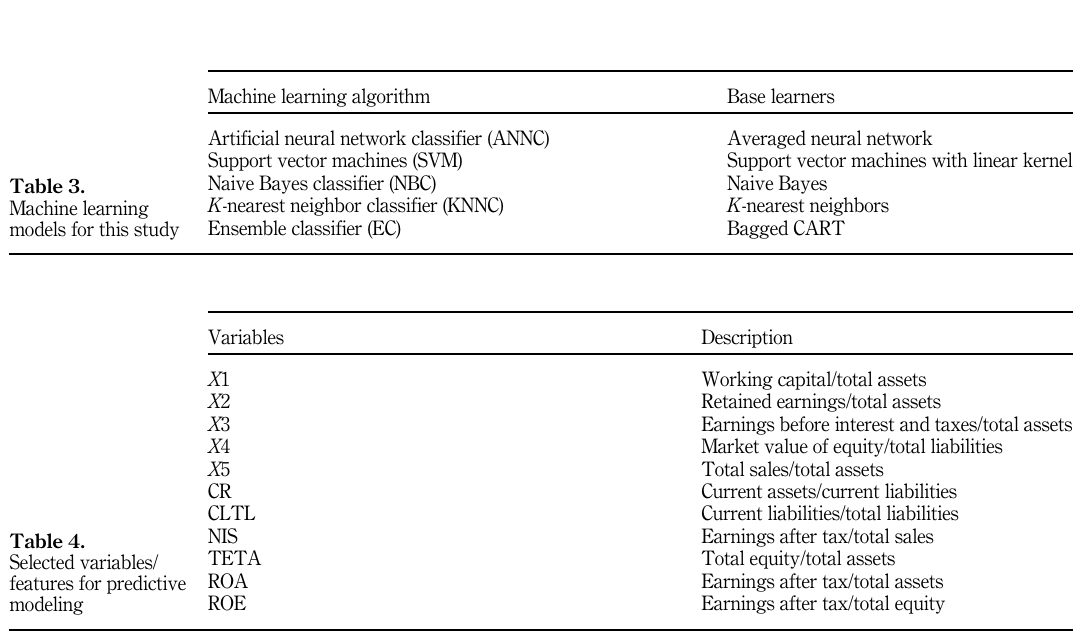
Table 2. Discriminant zones